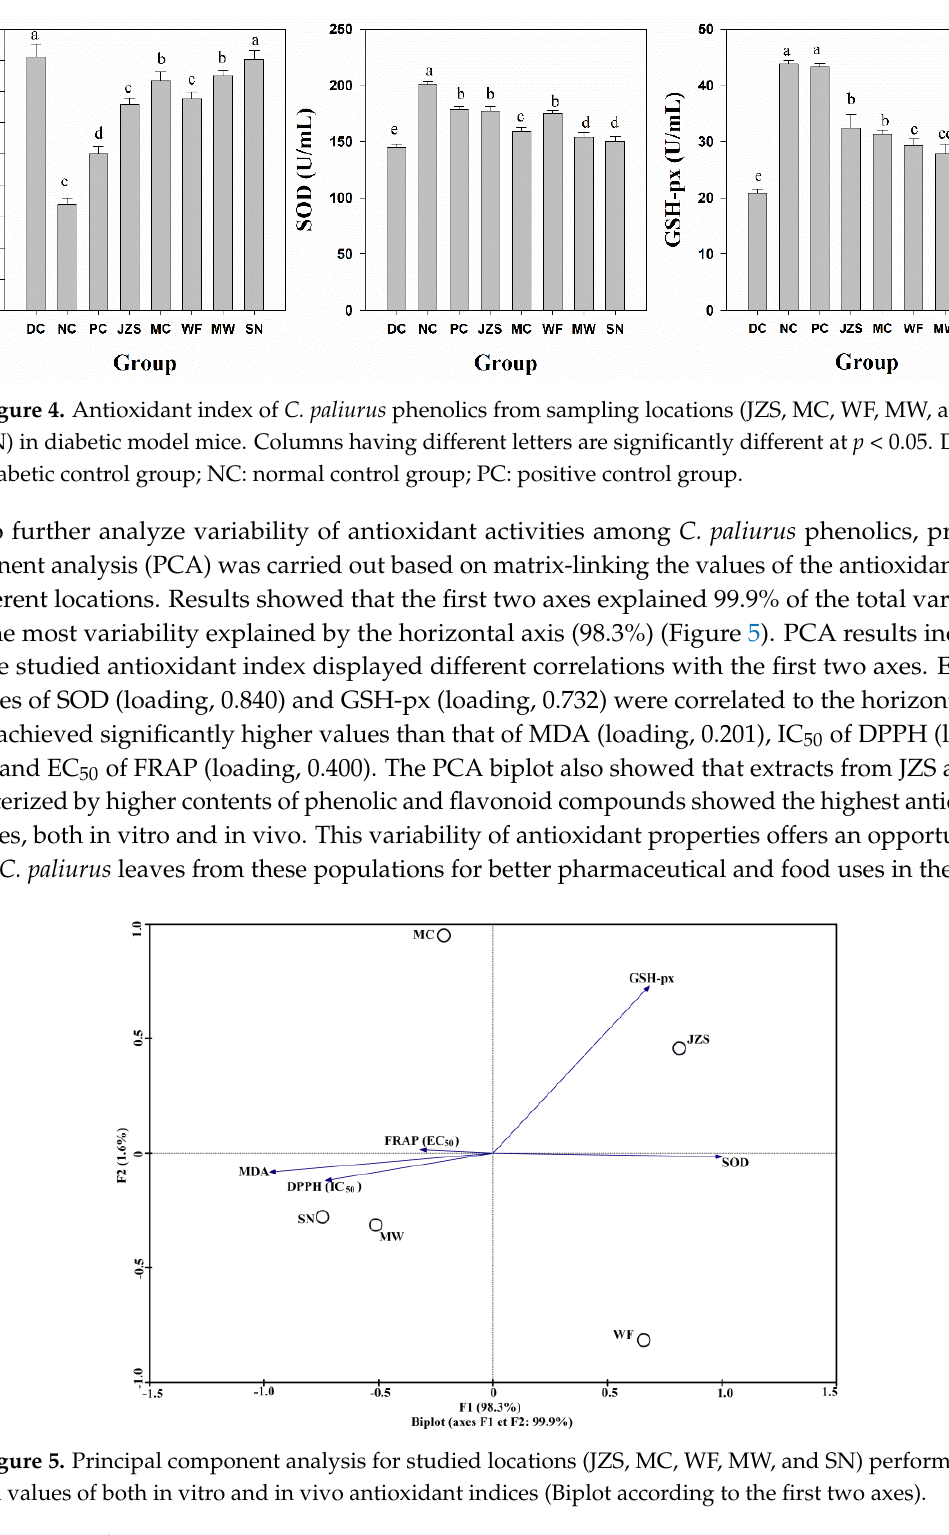
Table 3. Pearson correlation coefficients between phenolic compounds and antioxidant index (n = 15). DPPH (2,2-diphenyl-1-picrylhydrazyl) (IC 50 ): IC 50 of DPPH radical-scavenging activity; ferric-reducing antioxidant power (FRAP) (EC 50 ): EC 50 of FRAP; SOD: superoxide dismutase; GSH-px: glutathione peroxidase; MDA: malonaldehyde). Assays